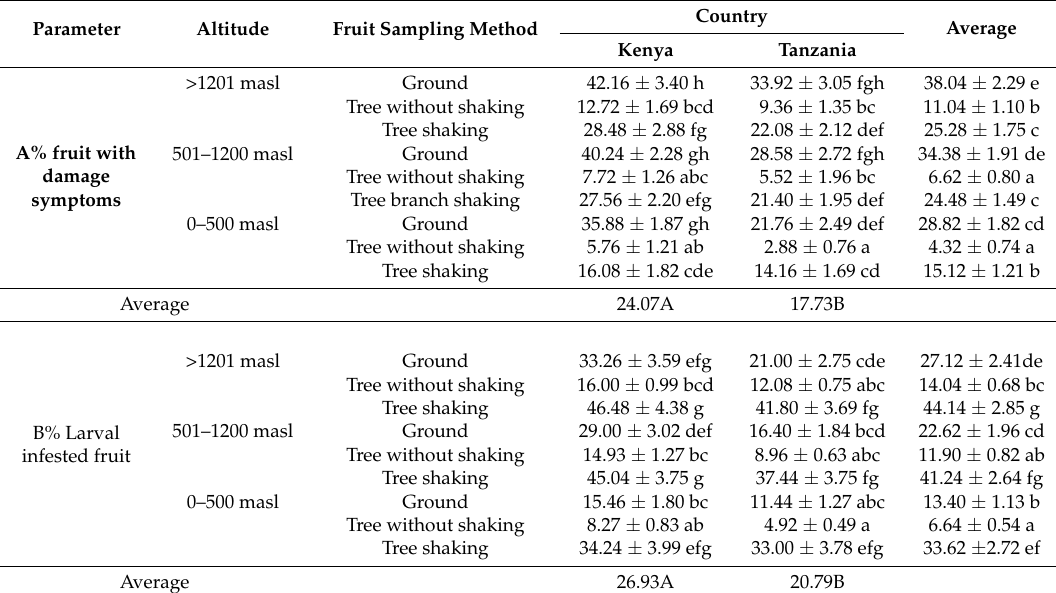
Table 2. Percentage of fruit with Thaumatotibia leucotreta damage symptoms (A) and larvae (B) sampled from the ground and from trees (with and without branch shaking) at the respective altitudes in Kenya and Tanzania.